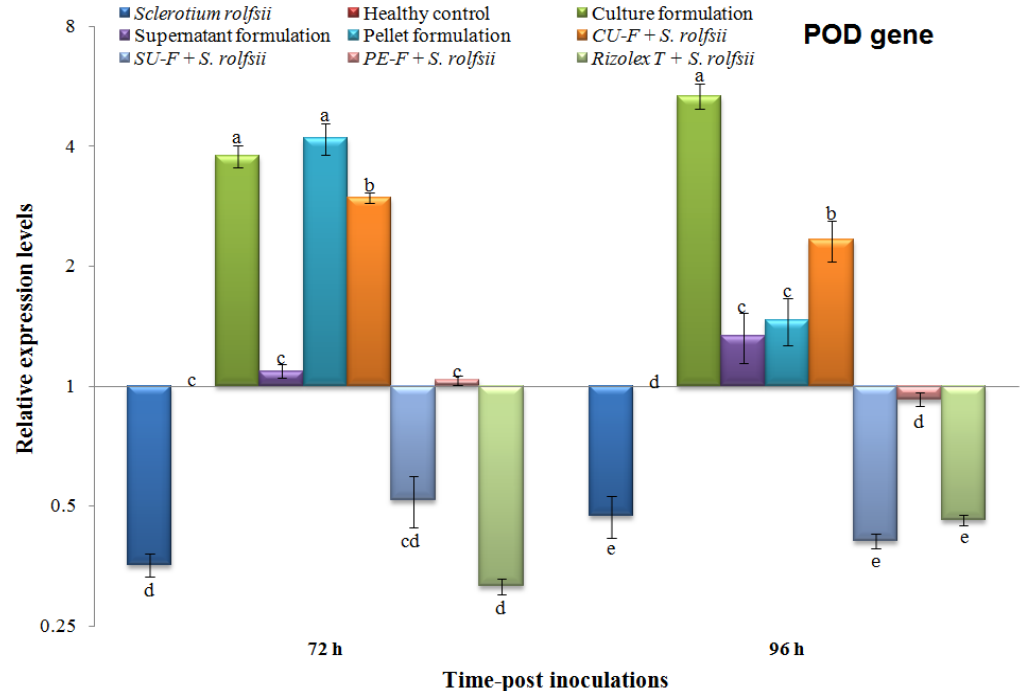
Figure 9. Relative expression levels of peroxidase ( POD ) gene in peanut plants at 72 and 96 h post-inoculation (hpi) of talc- based culture, supernatant, and pellet formulations of Streptomyces cellulosae Actino 48 in soil infected with Sclerotium rolfsii . Compared to the healthy control, the relative expression levels higher than 1 demonstrate an increase in gene expression (upregulation), while values lower than 1 indicate a decrease in expression levels (downregulation).